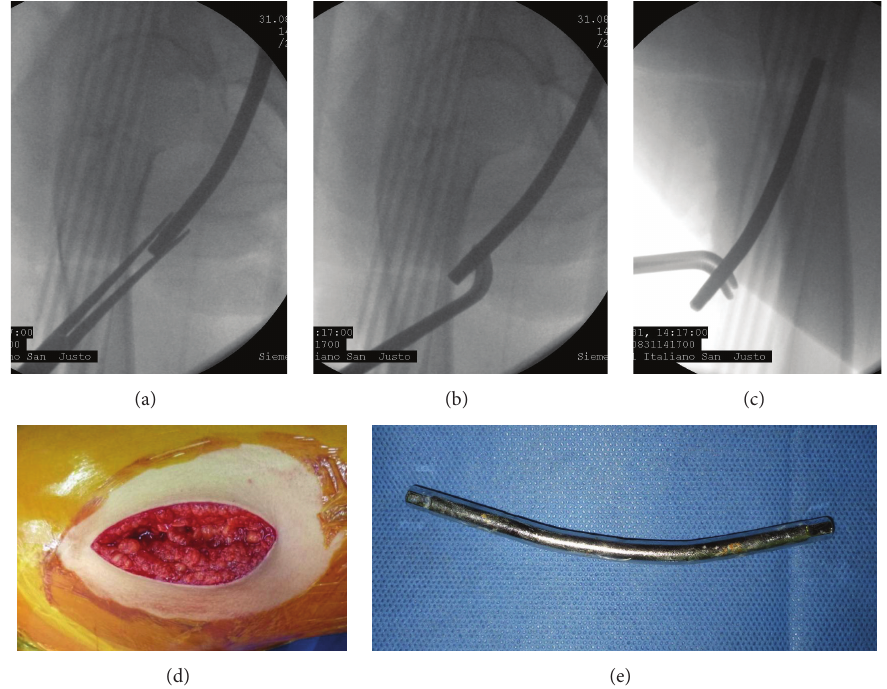
Figure 3: (a–c) Radioscopic rod pulled out. (d) Minimal anterior thigh approach. (e) Rod material removed.